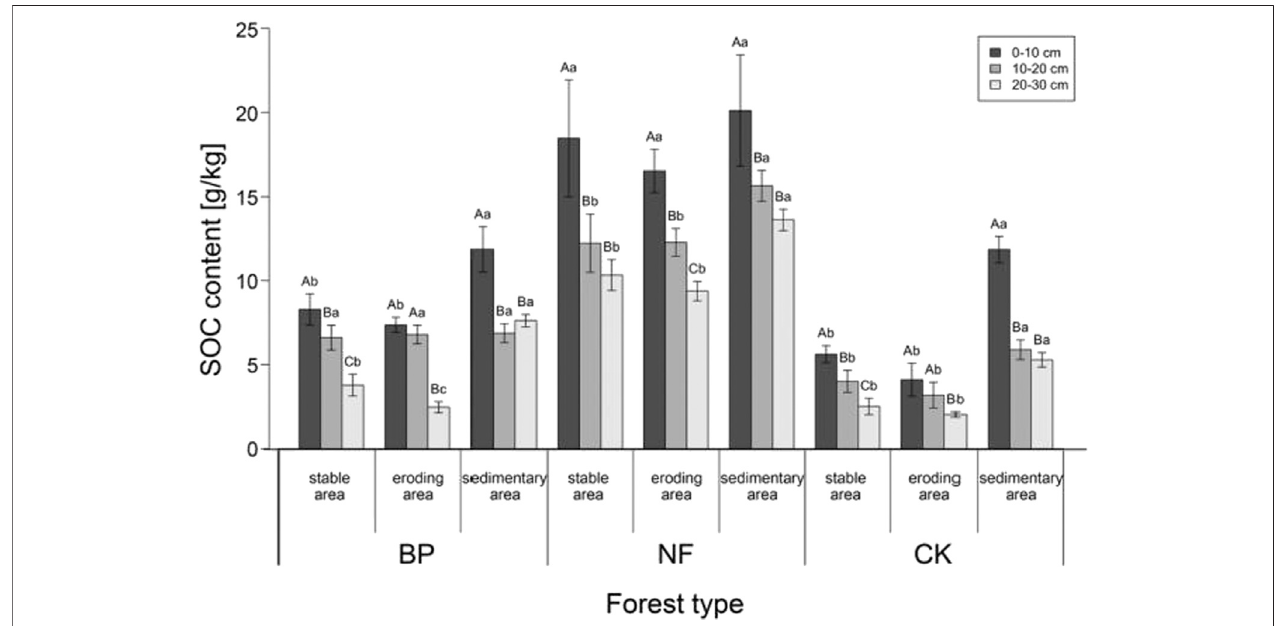
FIGURE 3 | Soilorganiccarbon content ofthe 0 – 30 cm soil layer (in 10 cm intervals) in the three areas de fi ned in Figure 2 under naturally regenerating forests (NF), black locustplantation(BP),andthecorn fi eldasthecontrol(CK).Verticalbarsrepresentthestandarddeviationsof fi vereplicatedsoilsamples.Differentcapitallettersforthesameareas indicate signi fi cant differences at p < 0.05 of soil layers, while different lowercase letters for the same soil layers indicate signi fi cant differences at p < 0.05 of different regions.